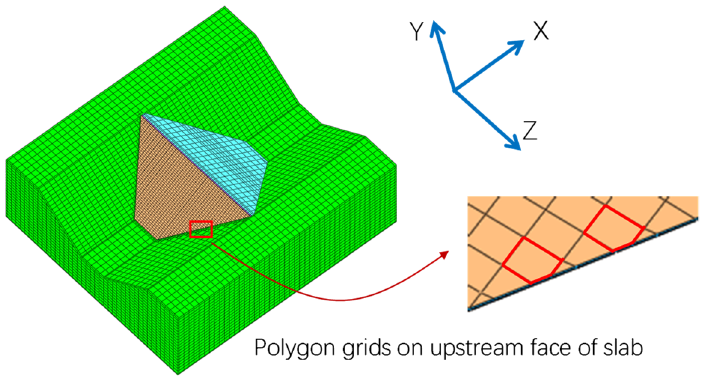
Figure 19. Cross-scale model of the CFRD and foundation.